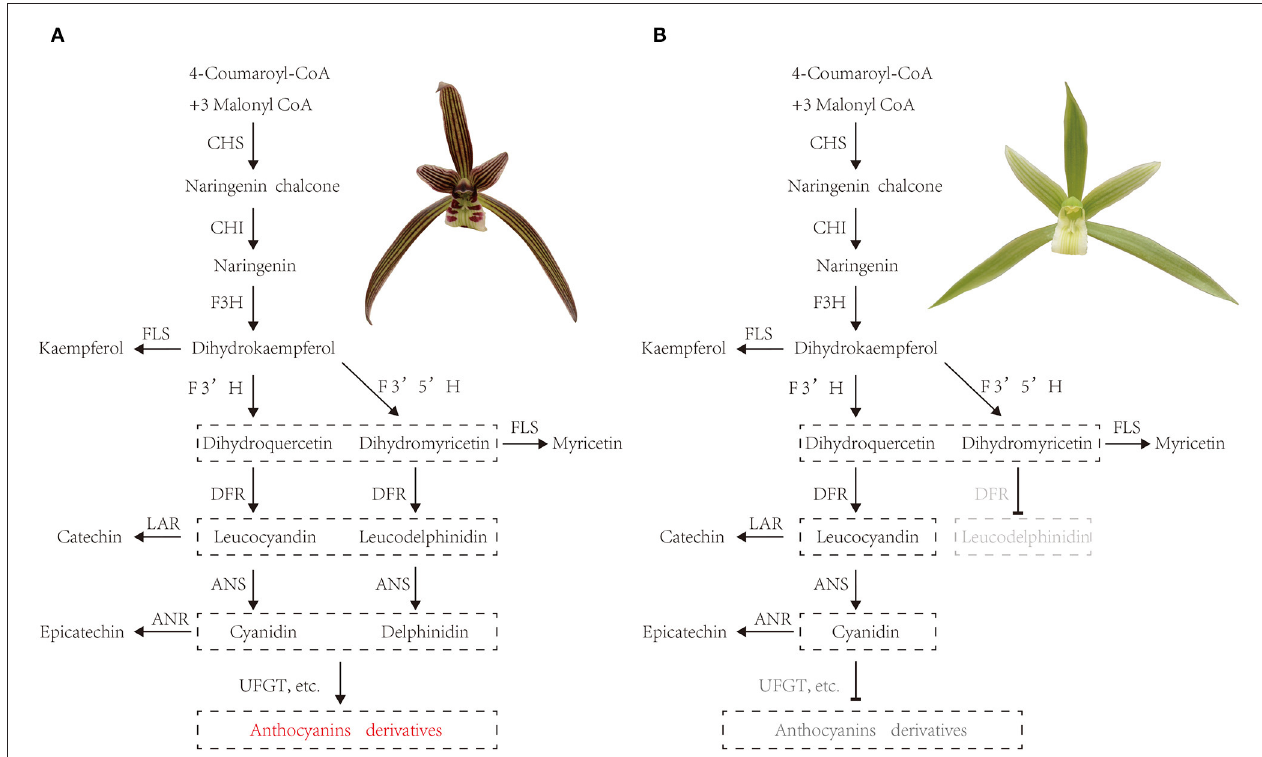
FIGURE 9 | Tentative pathways for (A) purple-red and white (B) C. kanran . CHS, chalcone synthase; CHI, chalcone isomerase; F3H, flavanone 3-hydroxylase; F3’H, flavonoid 3’-hydroxylase; F3’5’H, flavonoid 3’5’-hydroxylase; DFR, dihydroflavonol 4-reductase; ANR, anthocyanidin reductase; ANS, anthocyanidin synthase; FLS, flavonol synthase; LAR, leucoanthocyanidin reductase; UFGT, anthocyanidin 3-O-glucosyltransferase.